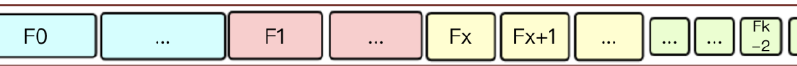
Figure 7. A sorted file list.